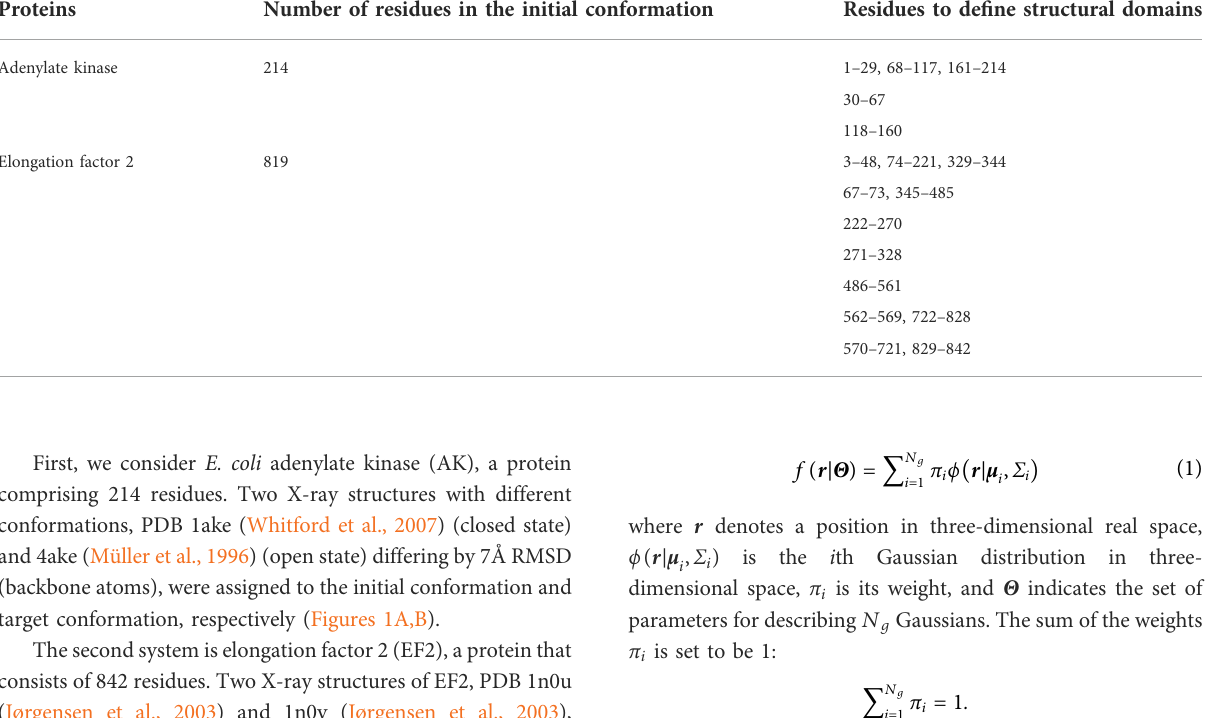
TABLE 1 Tested proteins and de fi nition of residue